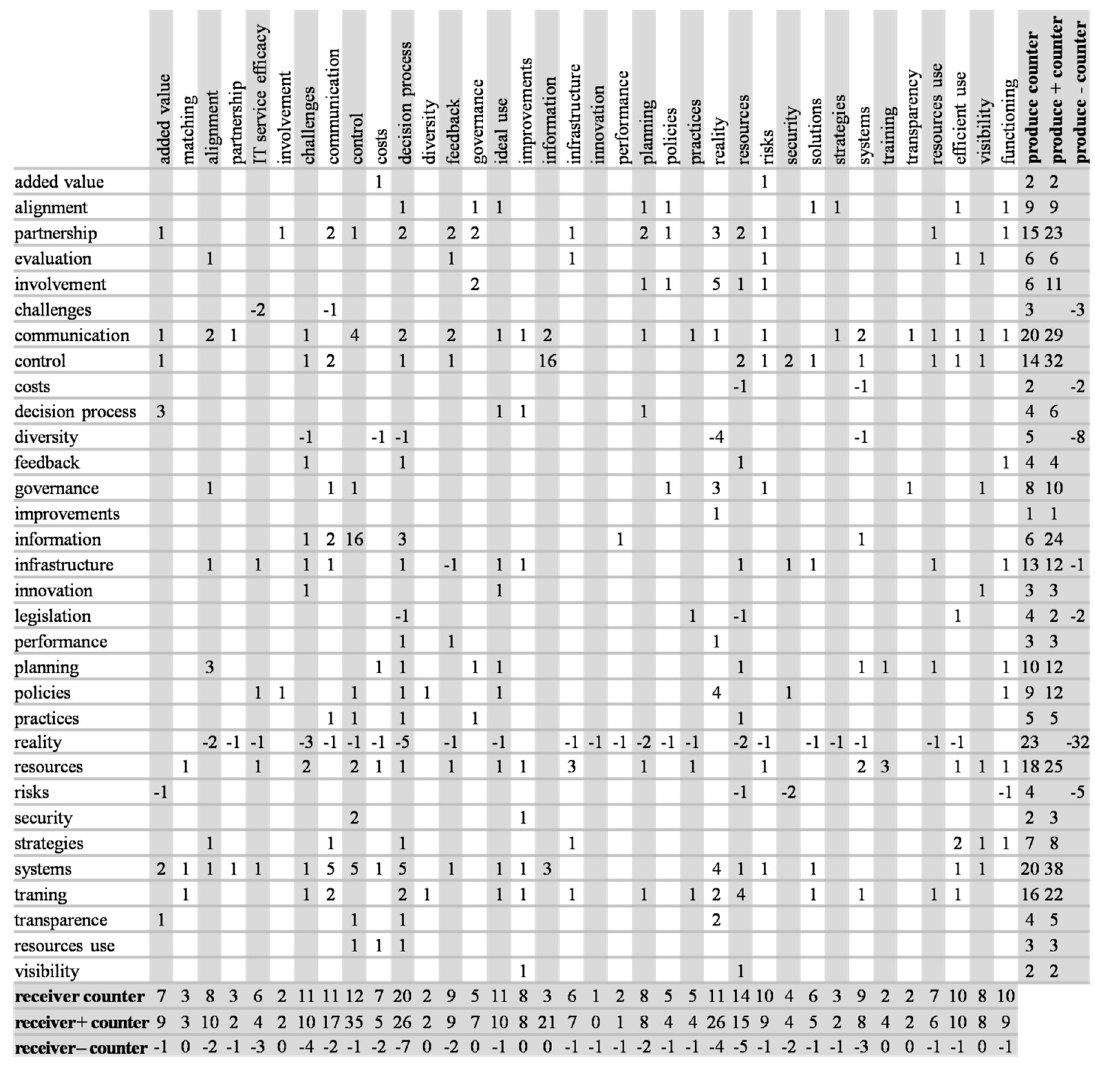
Figure 7. Interference Matrix.